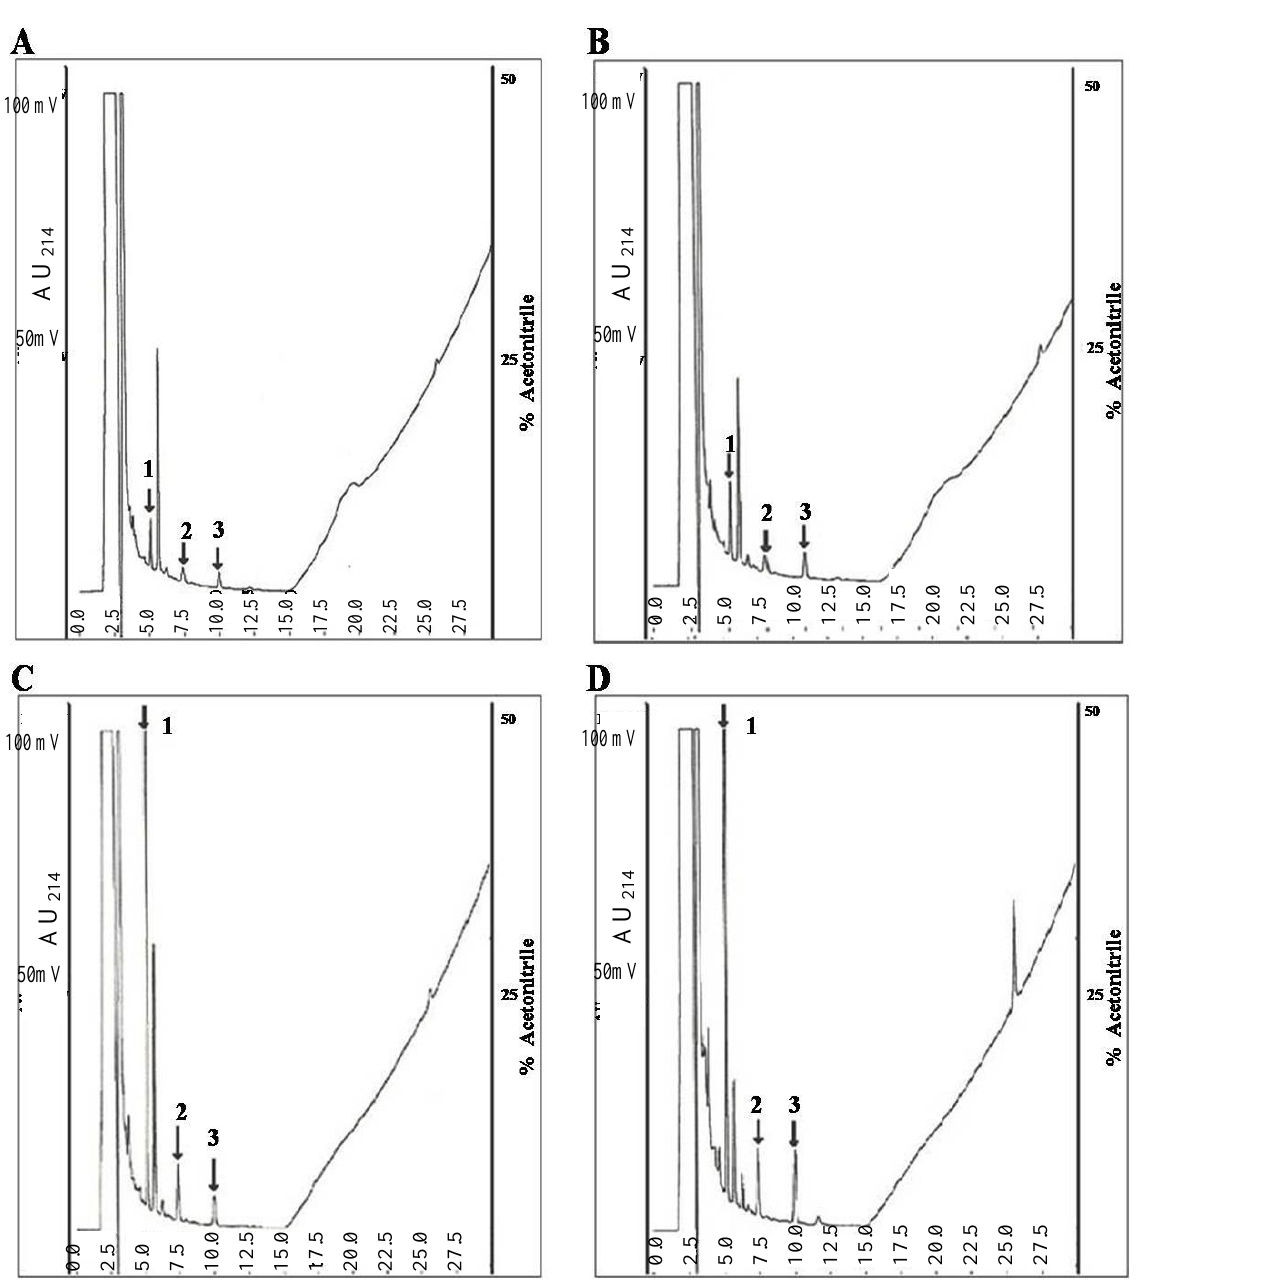
Figure 1. AFP-J protein partial digested with HCl. A sample (10 mg) of AFP-J purified pro tein was incubated with 1 N HCl at 60 °C for 2–24 h. A : 2 h, B : 4 h, C : 8 h, D : 24 h.